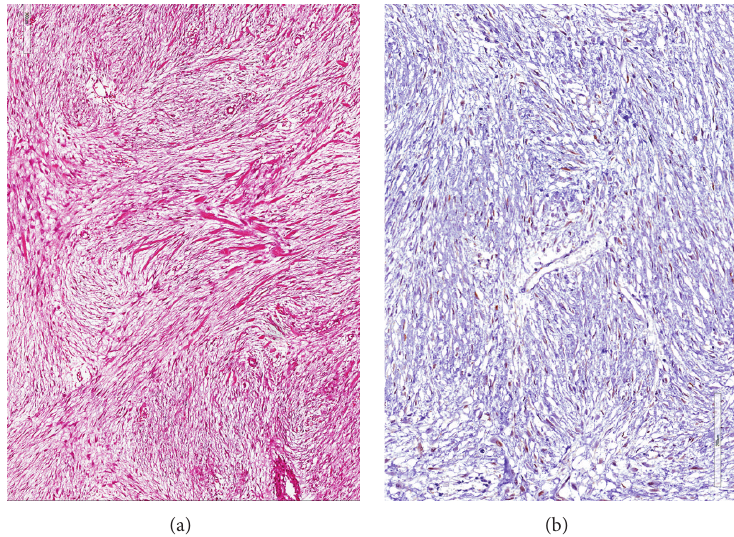
Figure 5: (a) Area of desmoid-type fibromatosis showing extensive myxoid stroma with interspersed keloid-like collagen fibers (hematoxylin and eosin; magnification × 100). (b) Immunostaining for beta-catenin shows nuclear expression in neoplastic cells (immunoperoxidase staining; magnification ×